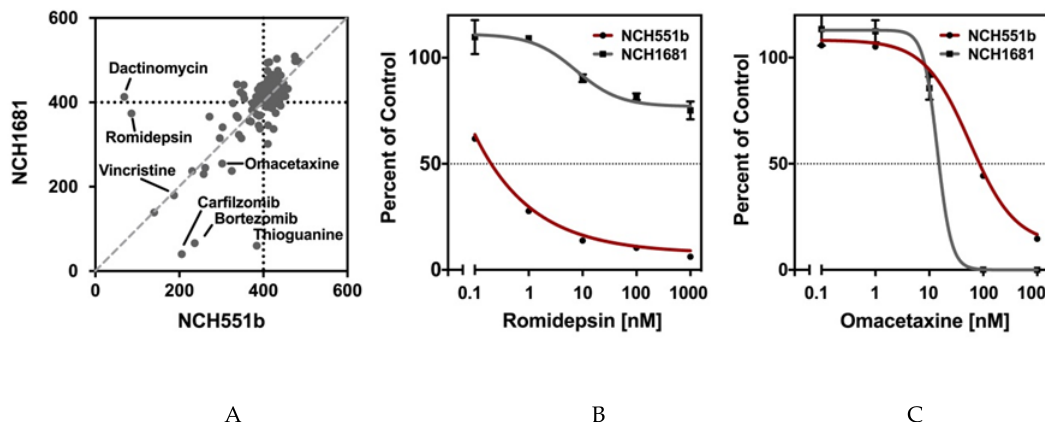
Figure 3. NCH551b and NCH1681 were chosen for the initial drug screen. ( A ) Most of the drugs clustered around an AUC of 400m suggesting little to no growth inhibition. ( B ) Some compounds showed an inhibition in only one of the cell lines (e.g., romidepsin NCH551b). ( C ) Compounds were considered for further analyses when growth inhibition was observed in both cell lines (e.g., omacetaxine).